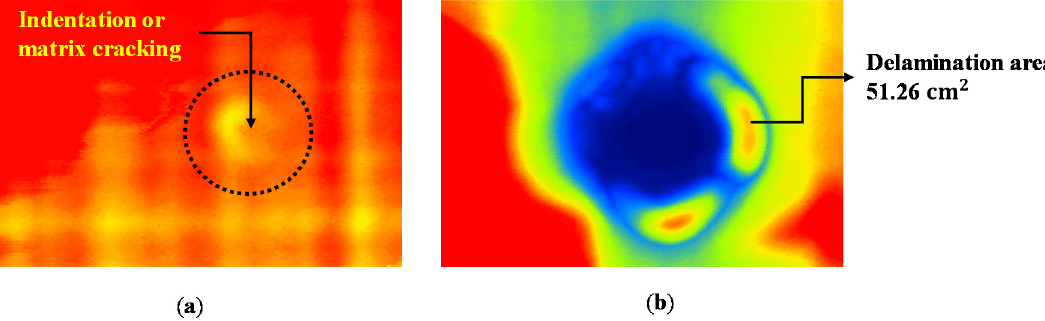
Figure 6. Ultrasonic C-scan images from the impact by R = 4 mm: ( a ) intact specimen (9 J impact) and ( b ) damaged specimen (12 J impact).